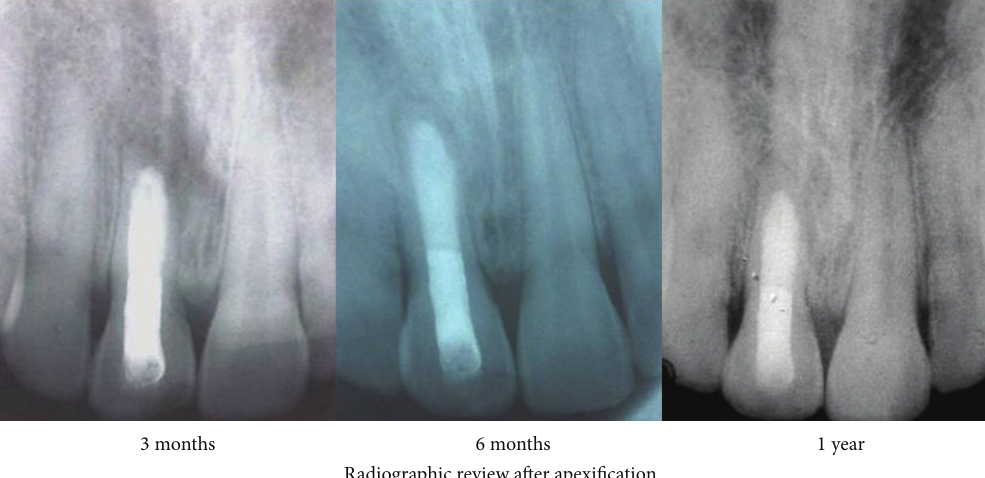
Figure 2: Postoperative radiographs after apexification.